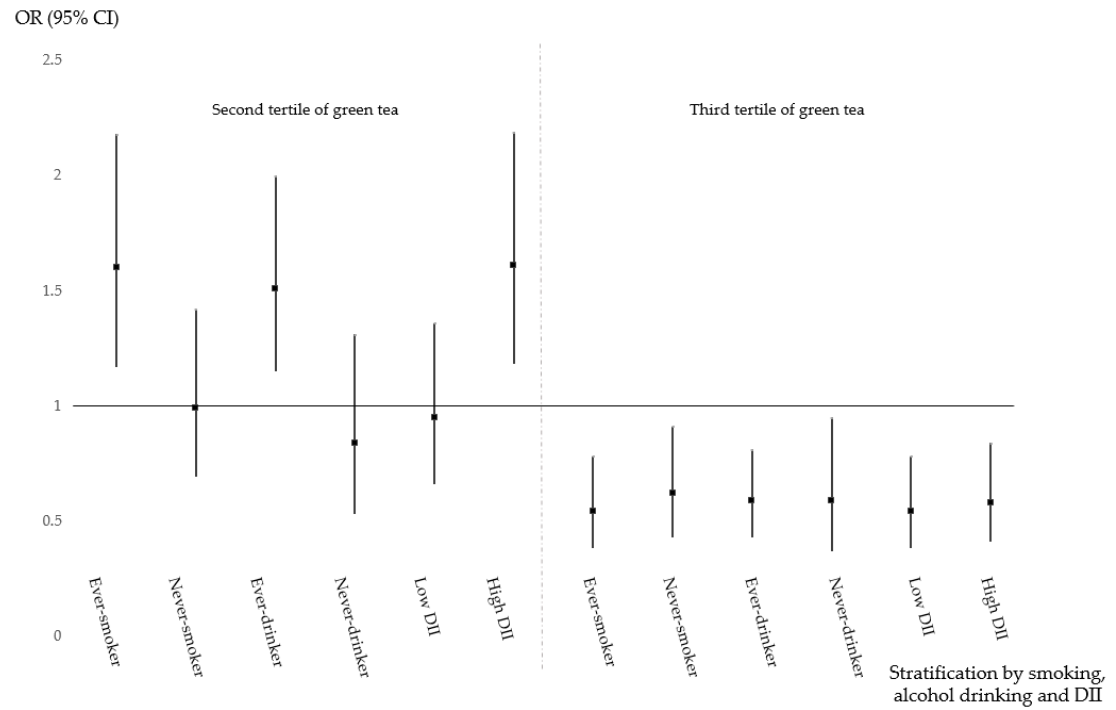
Figure 1. Green tea consumption and the risk of CRC stratified by demographic characteristics.